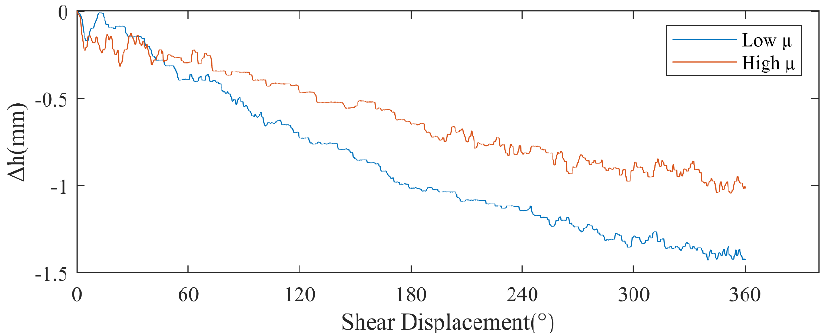
Figure 3. Vertical displacement versus shear displacement of quartz sand and brecciated corundum